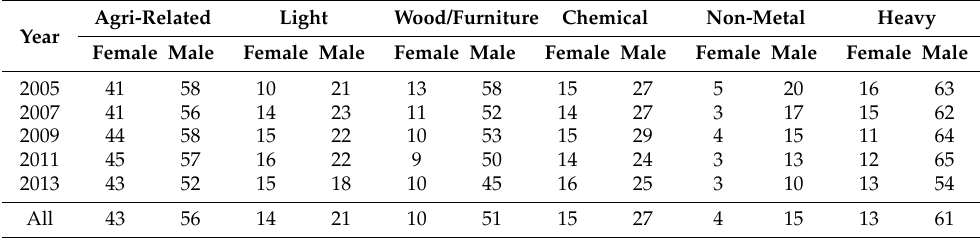
Table 5. Shares of male-led and female-led firms by firm size (in percentage).